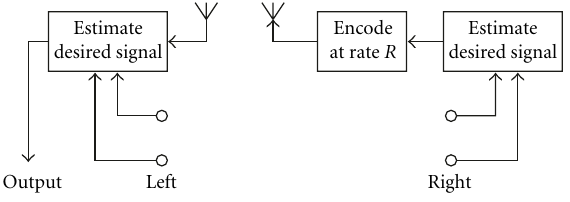
Figure 1: The scheme of [7]. The desired signal is first estimated from the right ear microphone signals, and then transmitted at a rate R . At the left ear, the desired signal is estimated from the received signal and the local microphone signals.